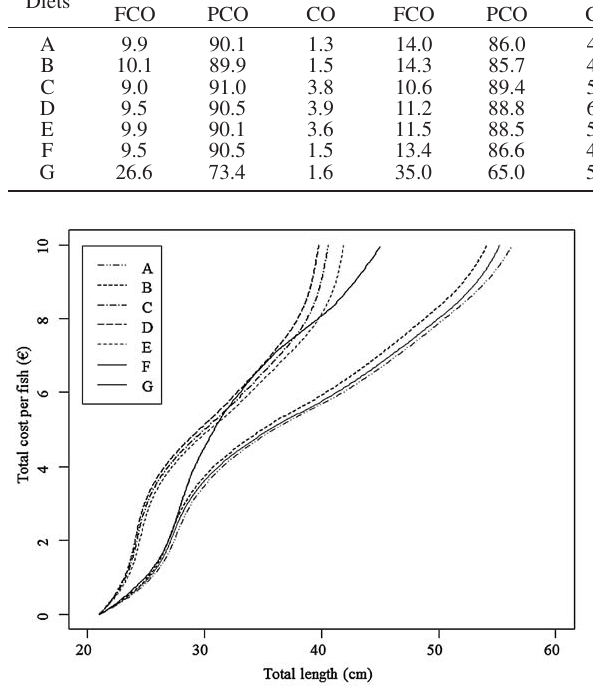
Fig. 4. – Size-dependent total cost (€) for a fish fed with each of the seven tested diets during the grow-out phase.